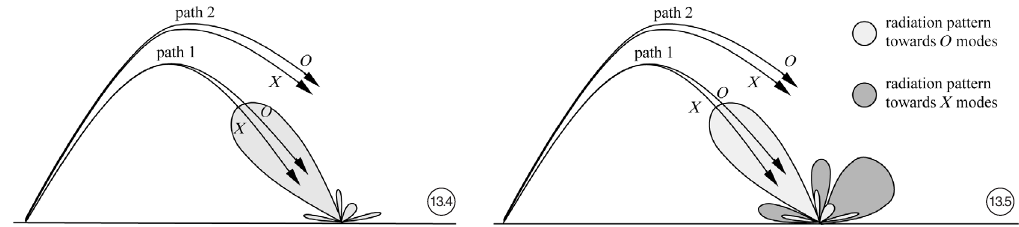
Fig. 13.2. Example of a signal fading (QAM-16, 3 kHz bandwidth, F ~ 8 MHz). Fig. 13.3. Time-frequency analysis of an HF signal at Intermediate Frequency IF = 2.25 kHz.